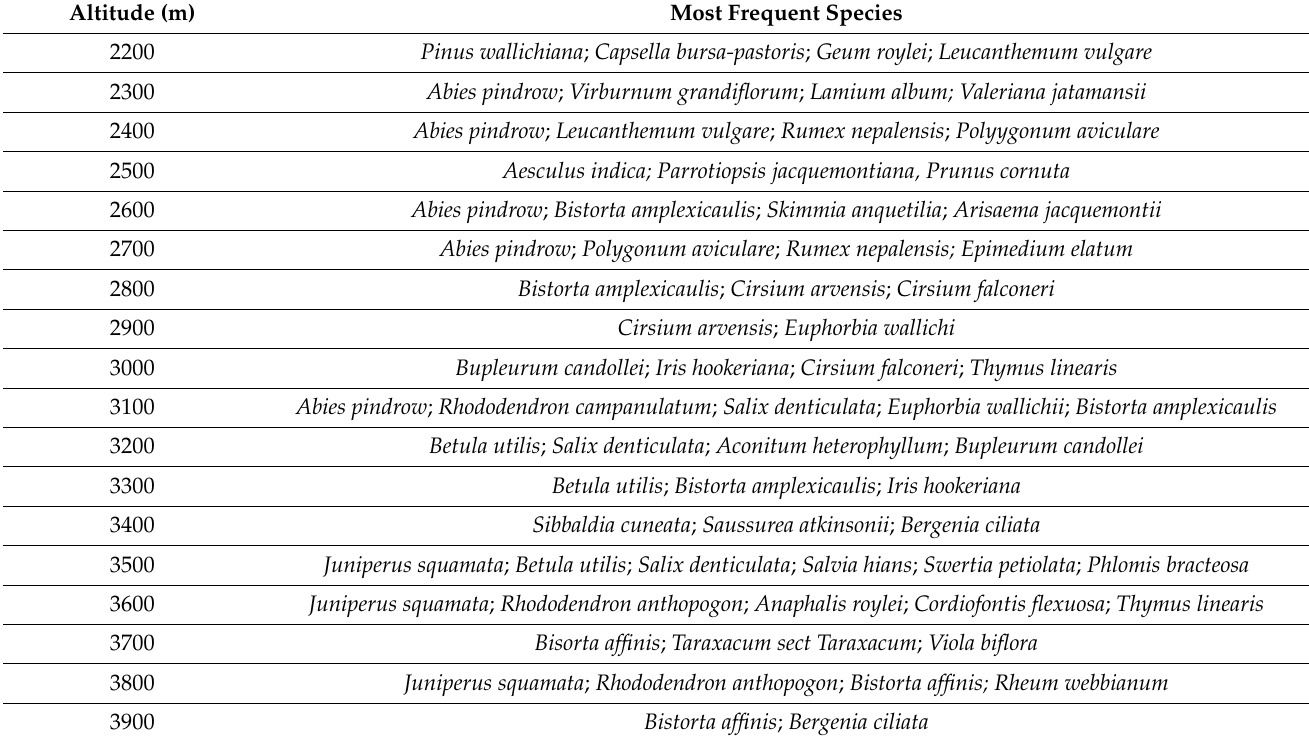
Table 1. Dominant plant species along the elevation gradient in GWLS, Kashmir Himalaya. Most Frequent